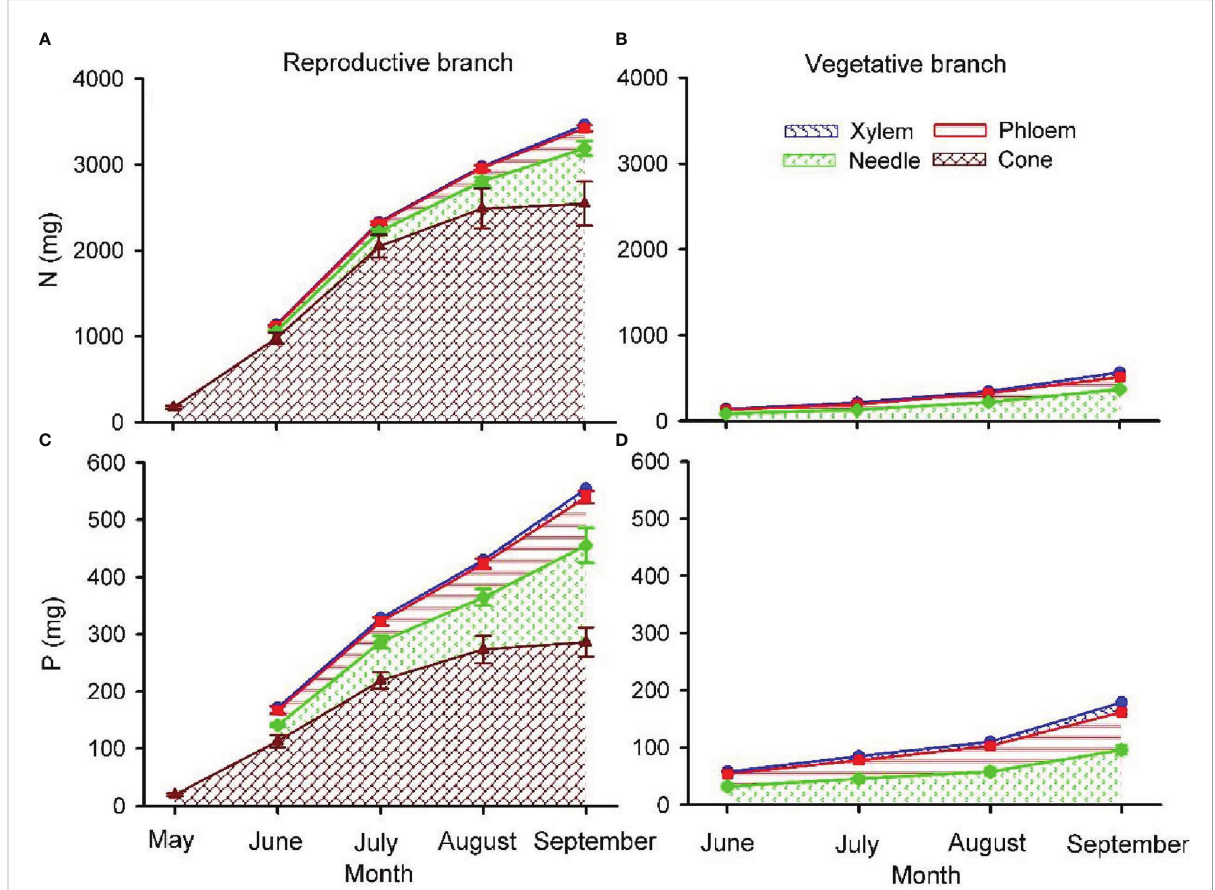
FIGURE 6 Total nitrogen ( N; A, B) and phosphorus ( P; C, D) content in cone, needle, phloem and xylem of one-year-old twigs of reproductive (A, C) and vegetative (B, D) branches of Pinus koraiensis . The area between lines with different colours indicates the nutrient content in needles, phloem, xylem and cones. Values shown are mean ± SE averaged from fi ve trees. Note that there were no one-year-old twigs in May when branches were